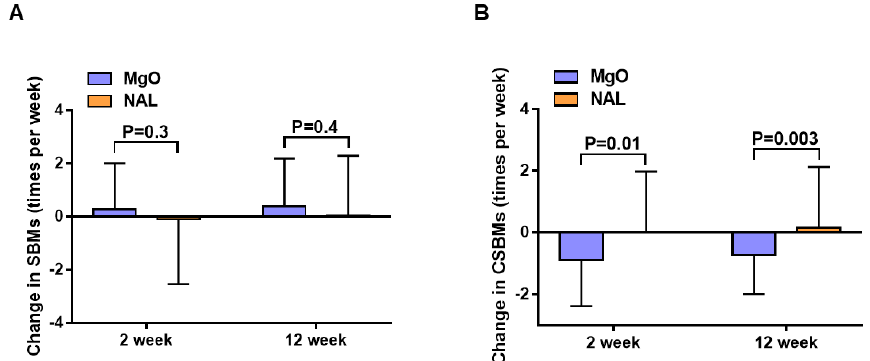
Figure 3. ( A ) Change in the number of spontaneous bowel movements (SBMs; times/week) from baseline to 2 and 12 weeks (after treatment) in the magnesium oxide group and the naldemedine group; and ( B ) change in the number of complete spontaneous bowel movements (CSBMs; times/week) from baseline to 2 and 12 weeks (after treatment) in the magnesium oxide group and the naldemedine group. Table 2. Efficacy in the 2- and 12-week randomized